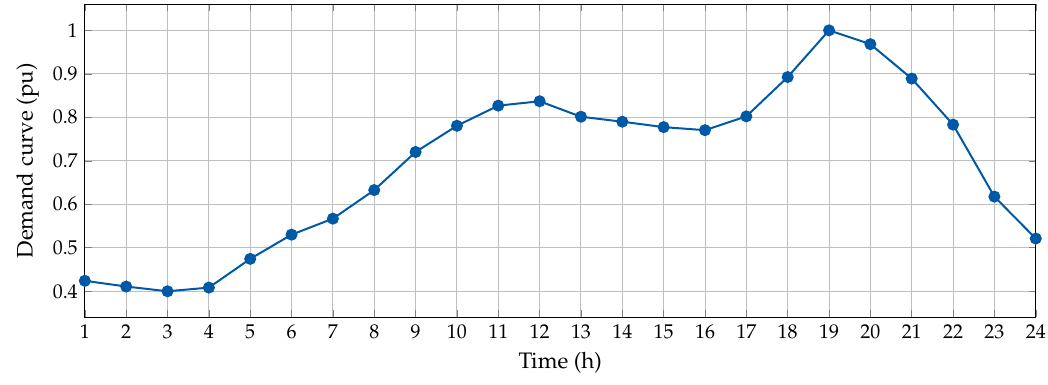
Figure 10. Typical demand load curve in residential networks in Colombia